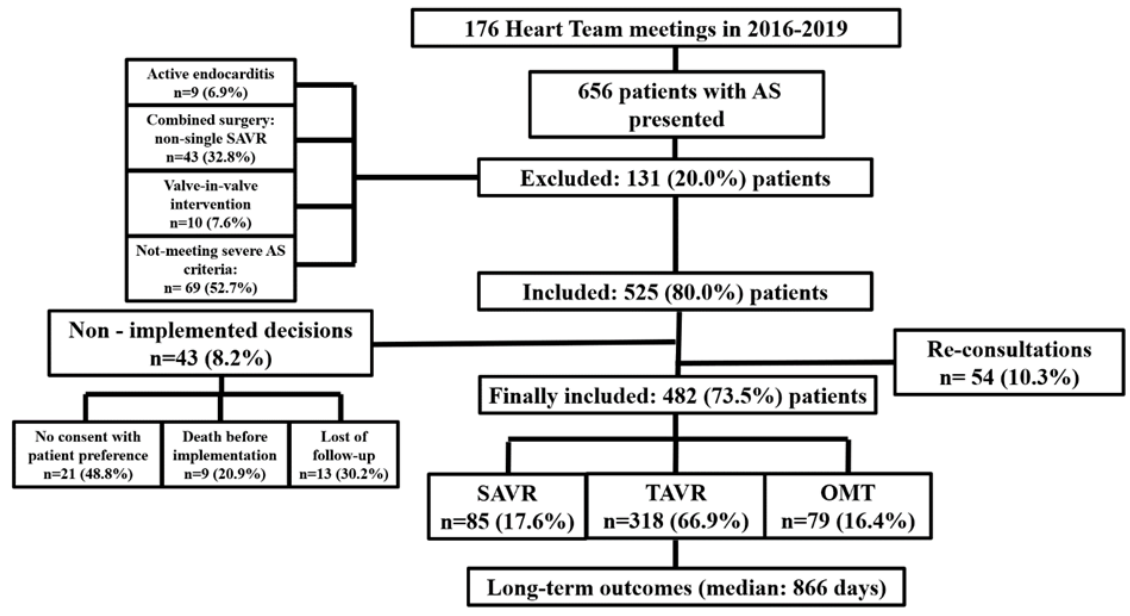
Figure 1. Study design. AS—aortic stenosis; TAVR—transcatheter aortic valve replacement; SAVR—surgical aortic valve replacement; OMT—optimal medical therapy.